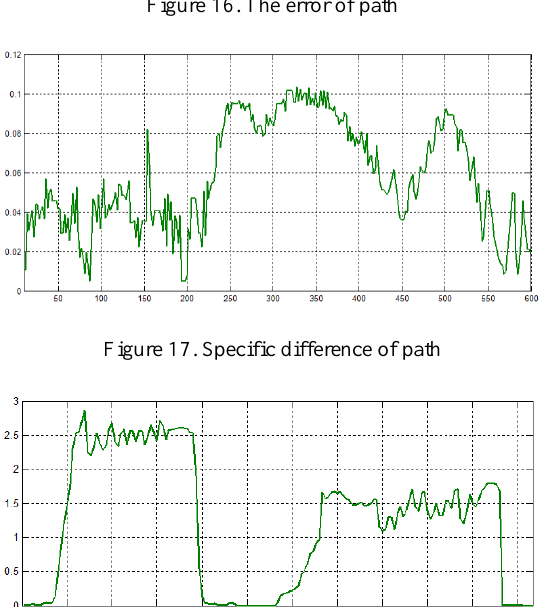
Figure 16. The error of path